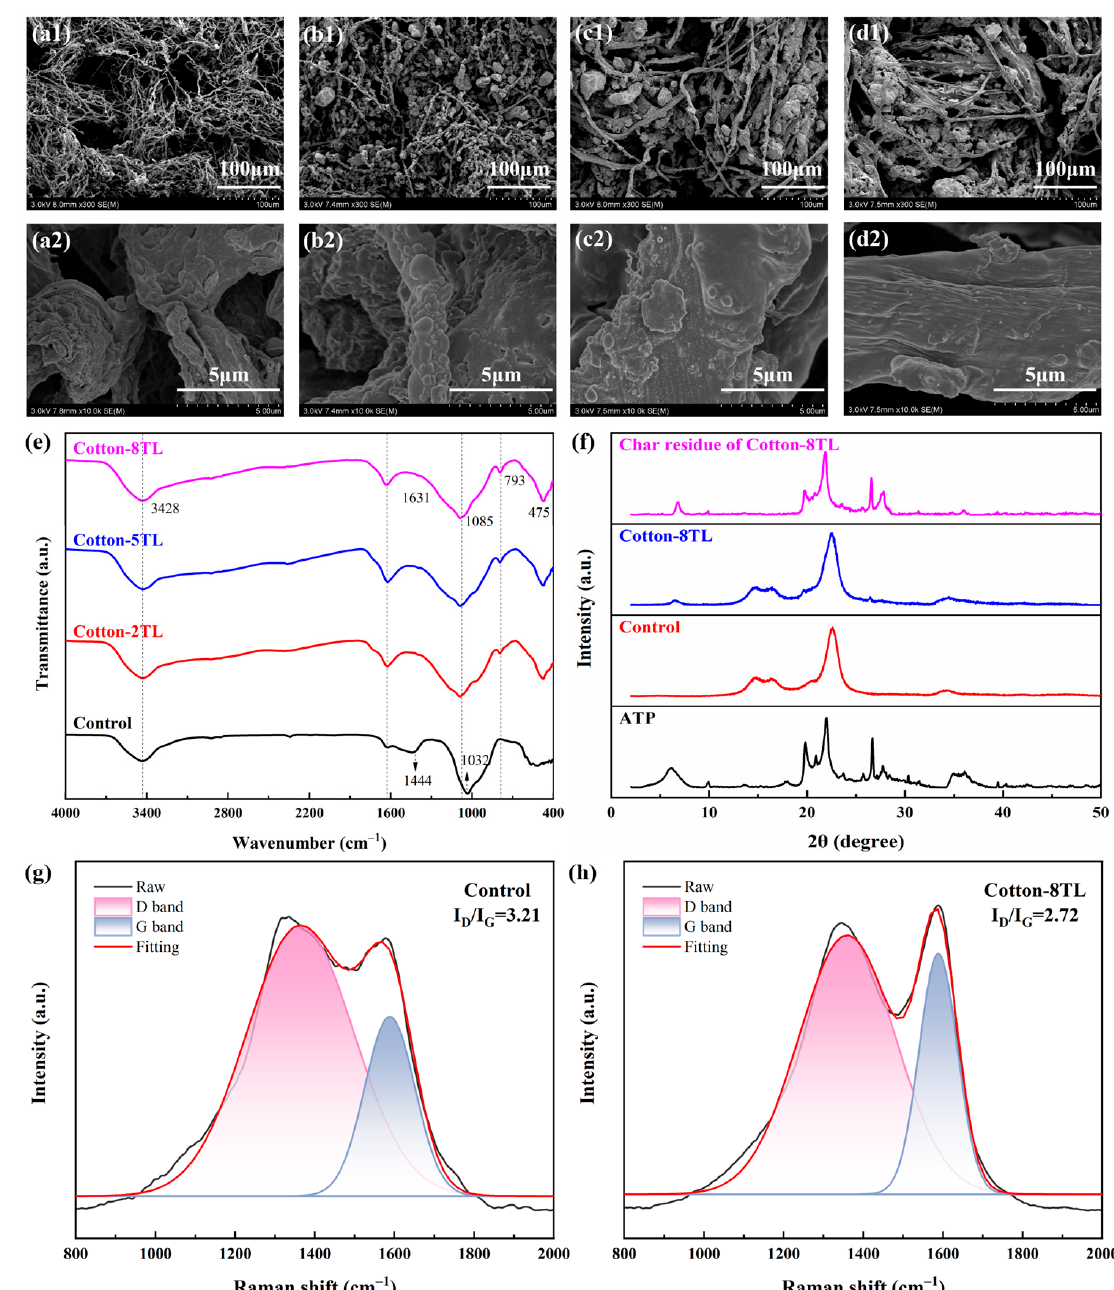
Figure 5. SEM images of ( a1 , a2 ) Control, ( b1 , b2 ) Cotton-2TL, ( c1 , c2 ) Cotton-5TL, ( d1 , d2 ) Cotton-8TL after CCT in different magnifications. ( e ) FTIR spectra of the char residue for the control and FR cotton fabrics after CCT. ( f ) XRD patterns of ATP, Control, Cotton-8TL, and Cotton-8TL char residue. Raman curves of char residue of ( g ) Control and ( h ) Cotton ‐ 8TL.